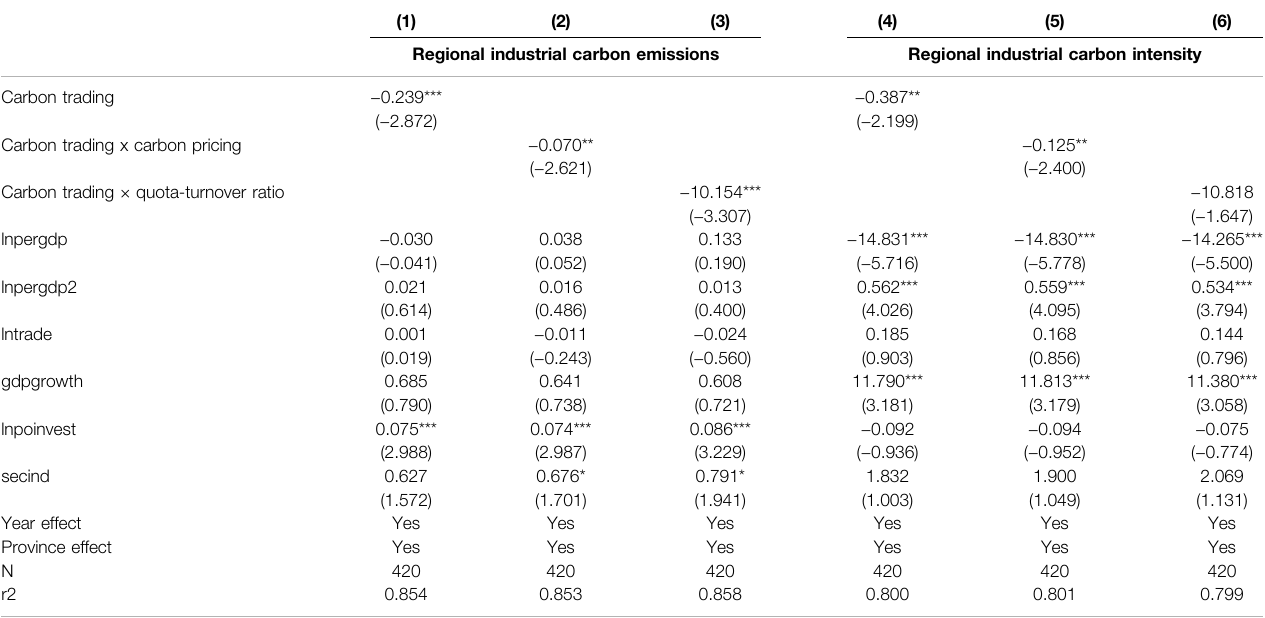
TABLE 2 | Impact of carbon trading on regional industrial carbon emissions: Benchmarking and